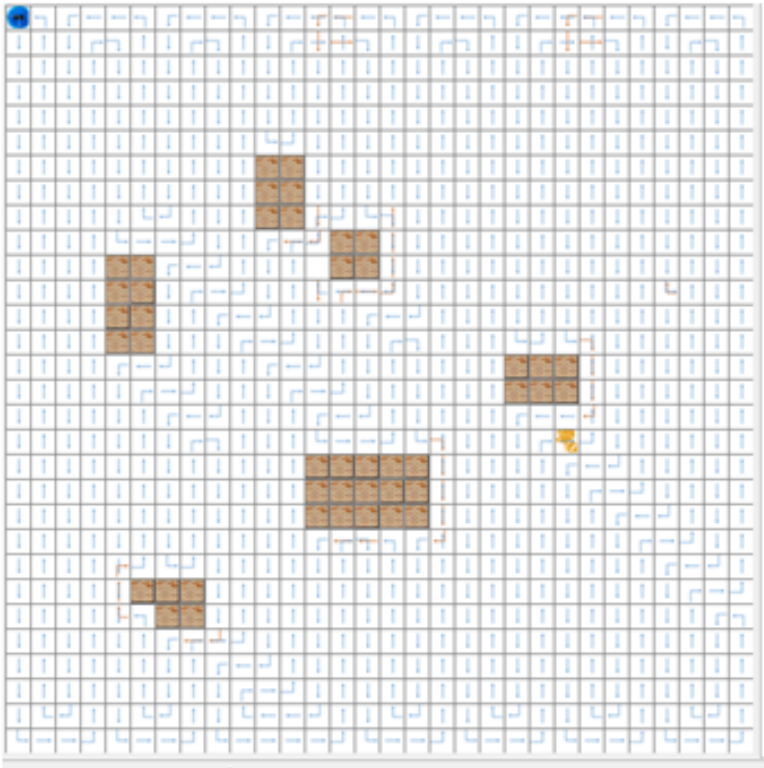
Figure 4. The cleaning robot applied to the proposed model using the basic cleaning function.